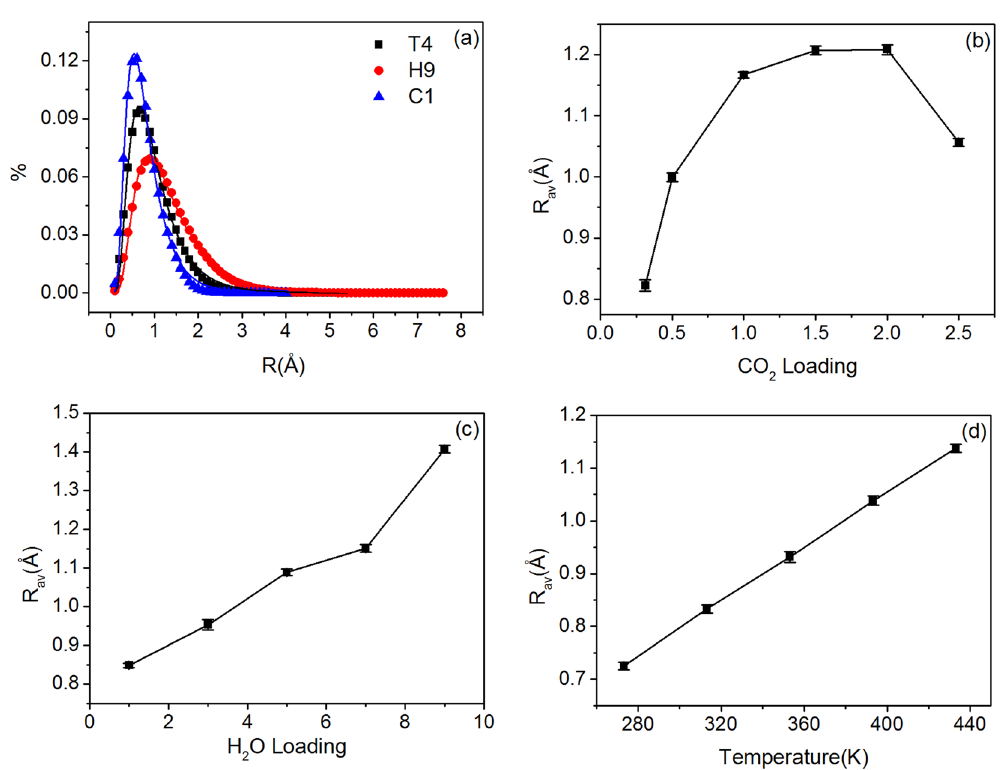
Figure 5. ( a ) Distributions of displacement and the fitted line in logarithmic normal distribution. The average displacement with different systems: ( b ) CO 2 loading; ( c ) H 2 O loading; ( d )